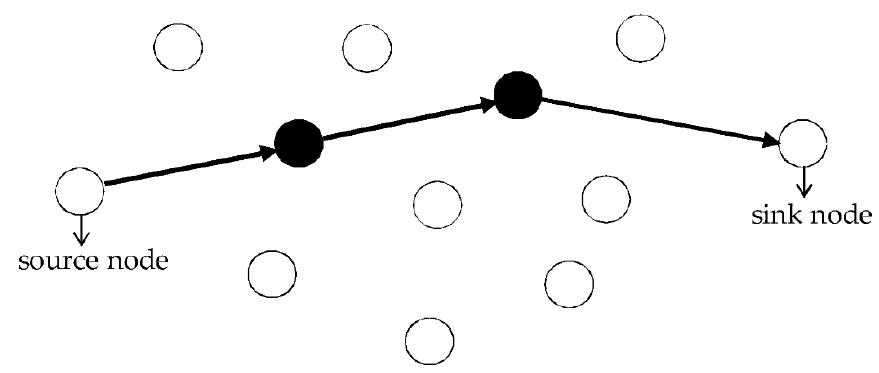
Figure 1. A schematic picture of a wireless (smart) sensor network (WSN).